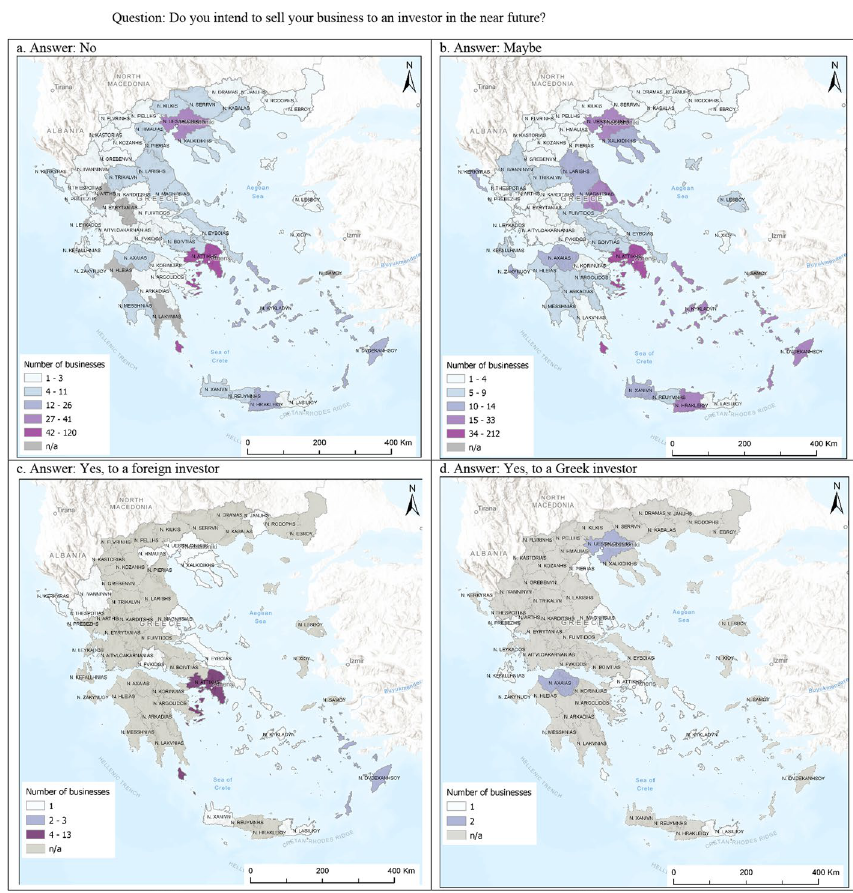
Fig. 2 Geographical distribution of business selling. Question: Do you intend to sell your business to an investor in the near